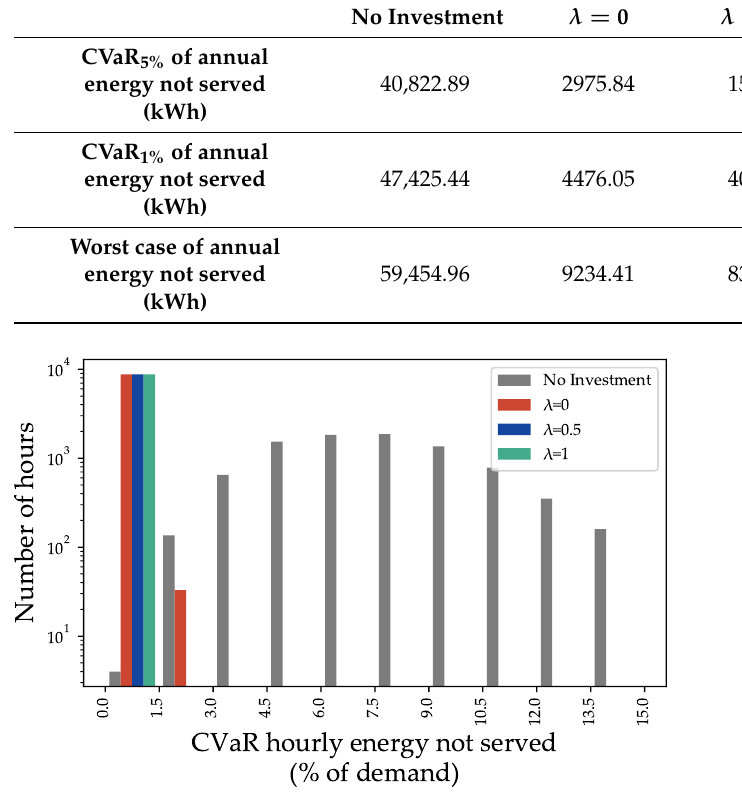
Figure 6. Out-of-sample analysis—CVaR 1% of hourly energy not served.